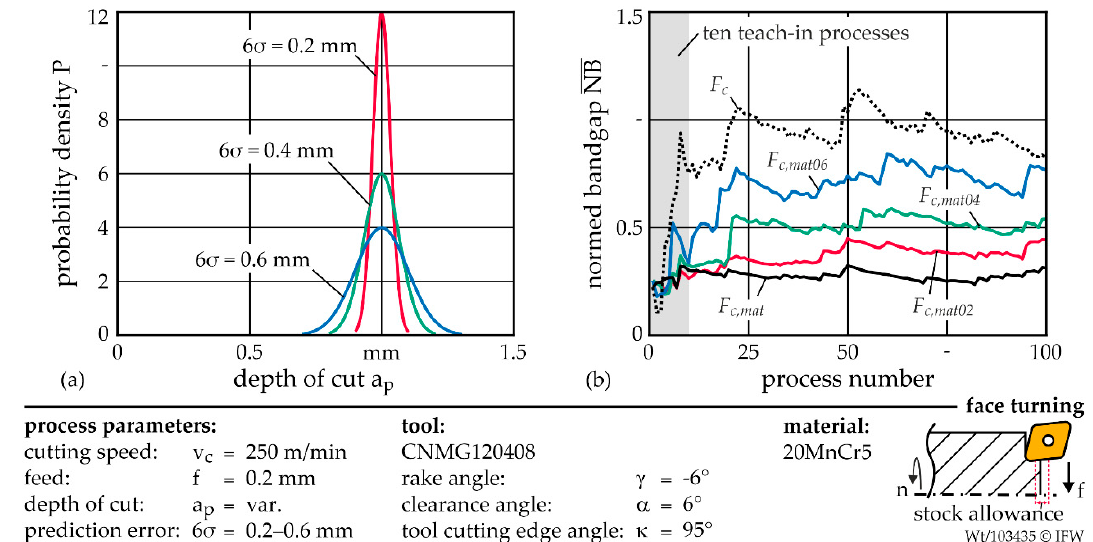
Figure 6. ( a ) Display of the probability density for three different prediction error ranges and ( b ) evolution of normed bandgaps for one hundred facing operations per series for stock allowance variation A, deviation of the predicted geometry A and the different prediction error ranges.